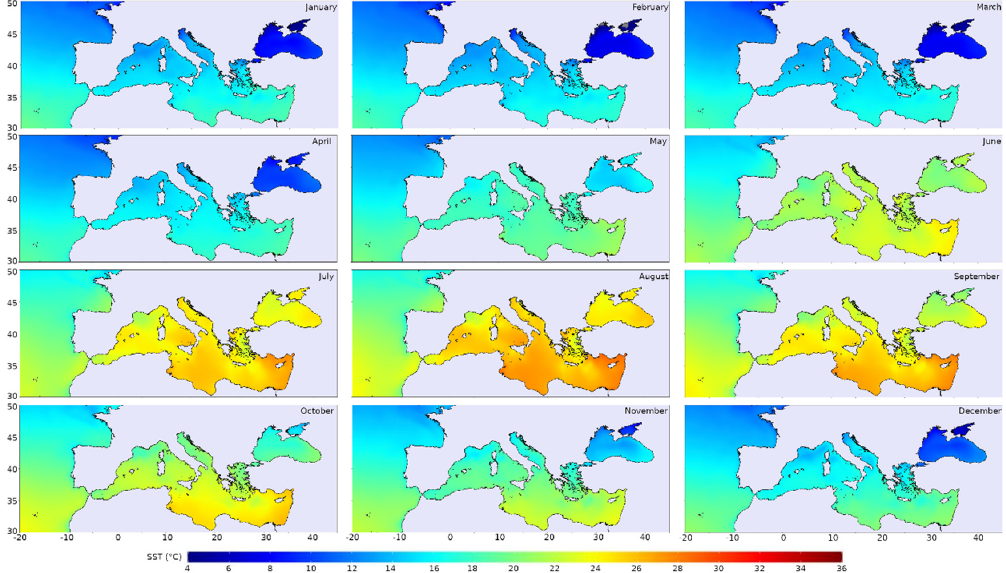
Figure 3. Monthly averaged SST for the global study period (1982–2019).